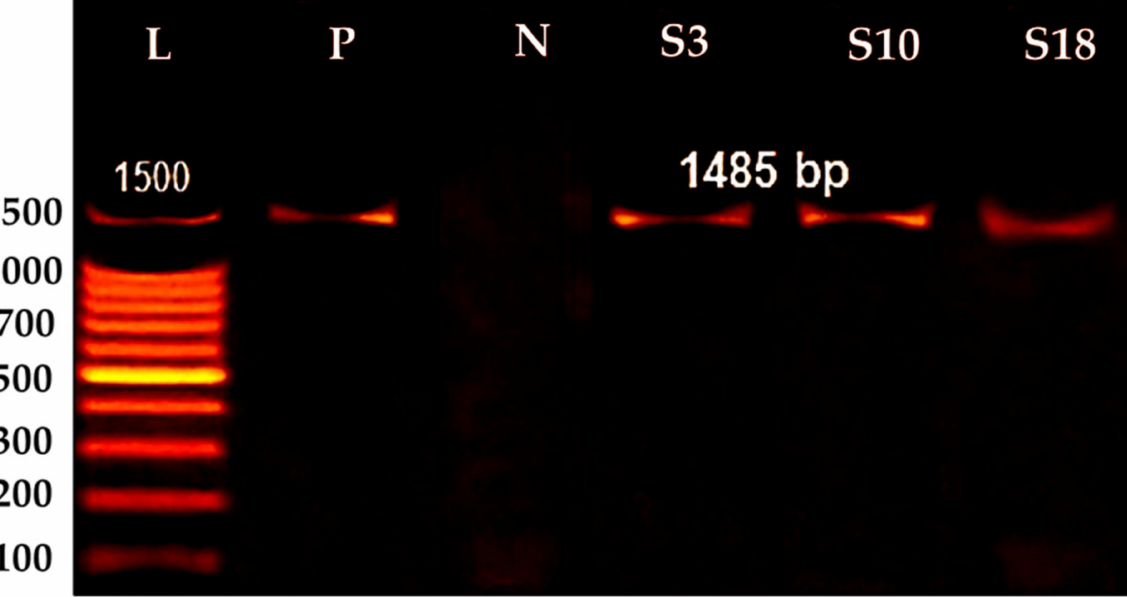
Figure 2. 16S rRNA genes of bacterial isolates, Lane 1, Ladder [(L) 100–1500 bp], Positive control (P, Pesudomonas areginosa ), Negative control (N, Aeromonas hydrophila ) identified isolates (S3, S10, and S18) at (1500